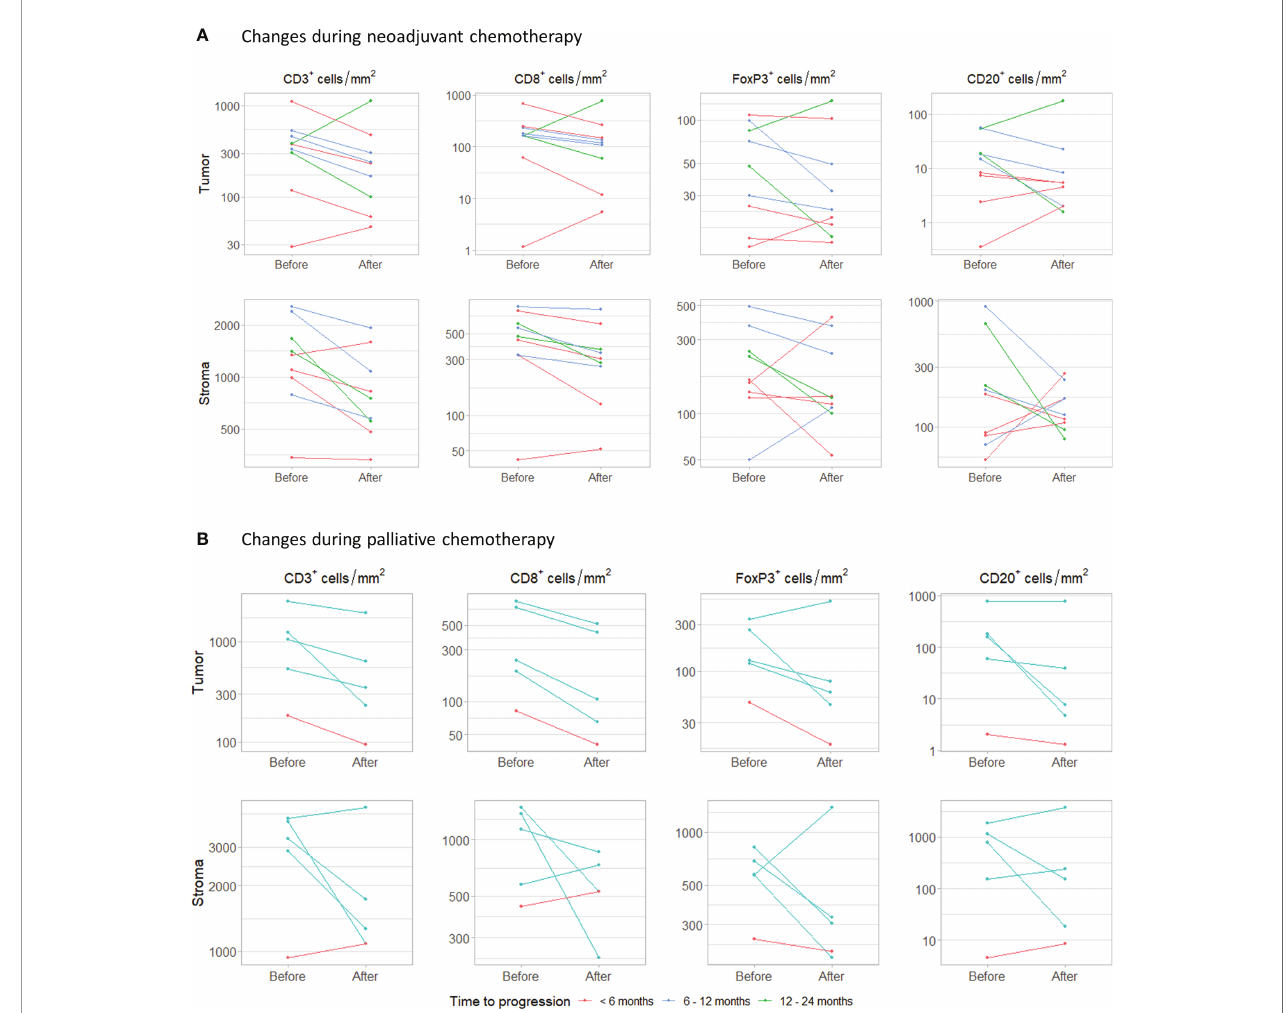
FIGURE 5 | Changes during chemotherapy. (A) Changes in intratumoral and stromal CD3 + , CD8 + , FoxP3 + and CD20 + cell density during neoadjuvant chemotherapy. Samples were obtained by transurethral resection (before) and cystectomy (after). (B) Changes during palliative platinum-based chemotherapy. Paired samples were obtained from the same tissue